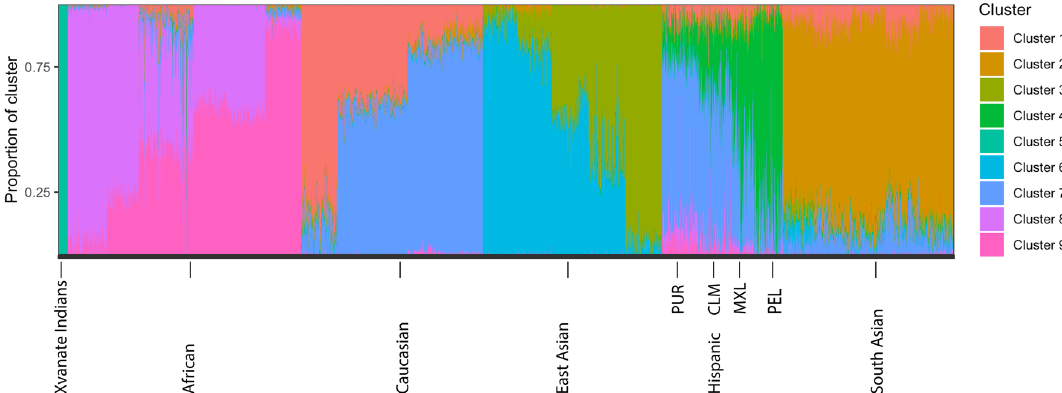
Figure 2. Global ancestry proportion of Xavante Indian samples and reference populations from 1000 genome project assuming K = 9 when analyzed using ADMIXTURE. Each color represents a unique genetic cluster identified by ADMIXTURE. PUR Puerto Ricans from Puerto Rico, CLM Colombians from Medellin, Colombia, MXL Mexican Ancestry from Los Angeles USA, PEL Peruvians from Lima,